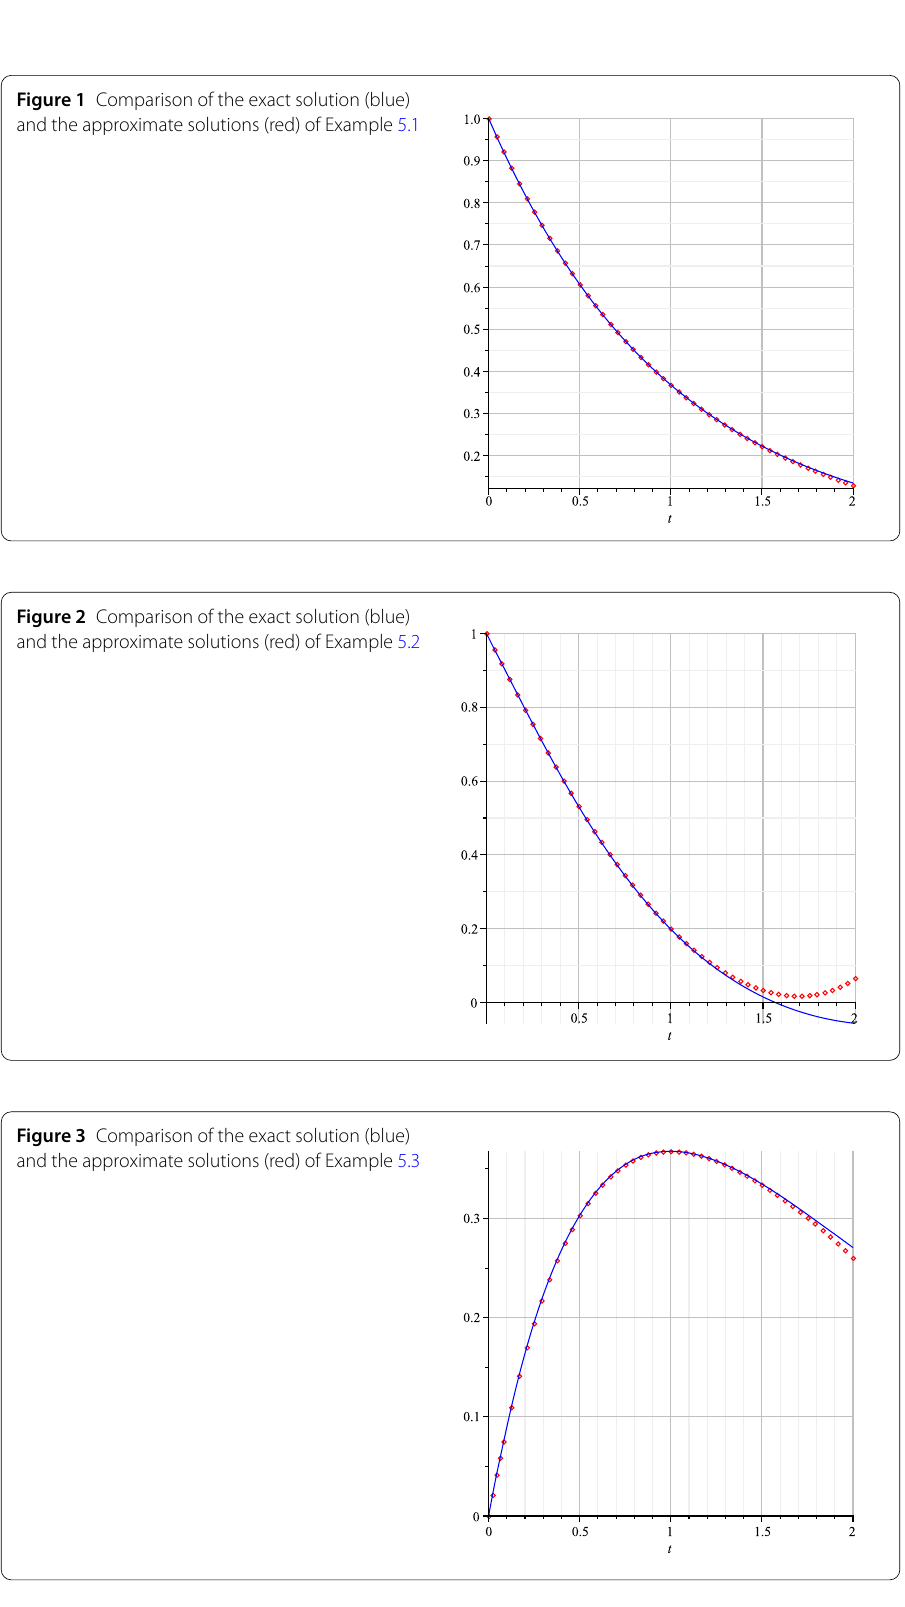
Figure 1 Comparison of the exact solution (blue) and the approximate solutions (red) of Example 5.1